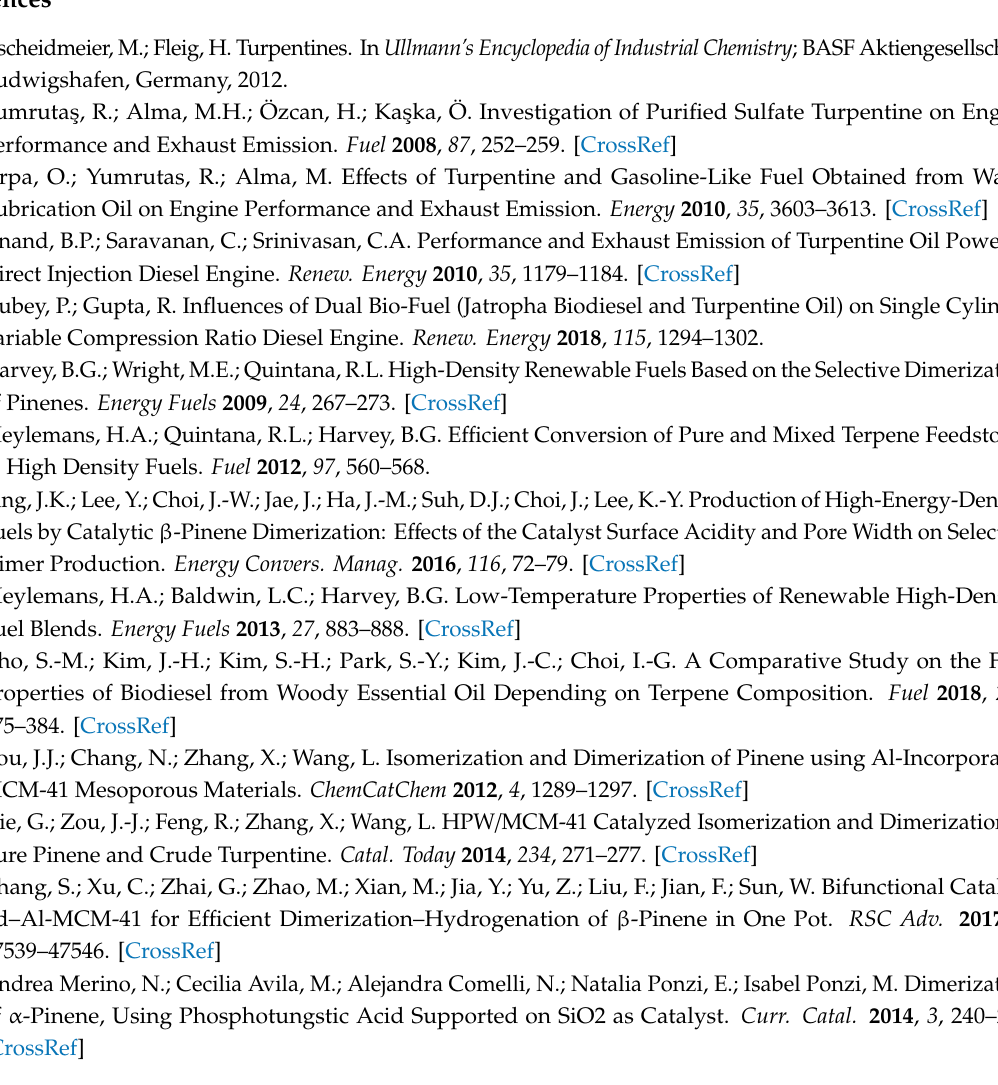
Figure S1: (a,b) Energy dispersive spectroscopy (EDS) spectra, (c,d) elemental quantitative data obtained from intact SnO 2 and SO 42 − / SnO 2 and (e) higher resolution of elemental mapping image of SO 42 − / SnO 2 , Figure S2: TGA curves of intact SnO 2 (black line) and SO 42 − / SnO 2 (red dashed line), Figure S3: The yields of the monomeric products along the reaction time at (a) 100 ◦ C and (b) 110 ◦ C, Figure S4: General chromatogram of dimeric products extracted from GC / FID